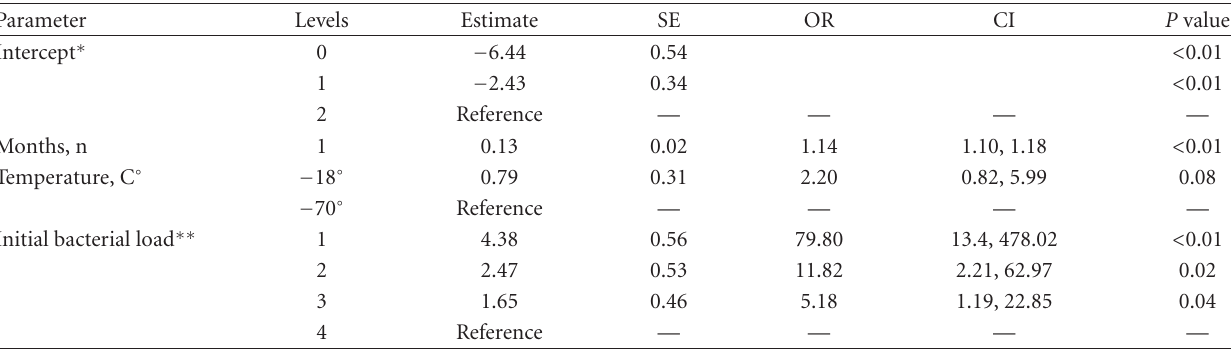
Table 1: Parameter estimates (standard error—SE, odds ratio—OR and the OR 95% confidence interval—CI) of the proportional odds mixed model for changes on the fecal culture results across time for Mycobacterium avium subsp . paratuberculosis in dairy cows in Minnesota,